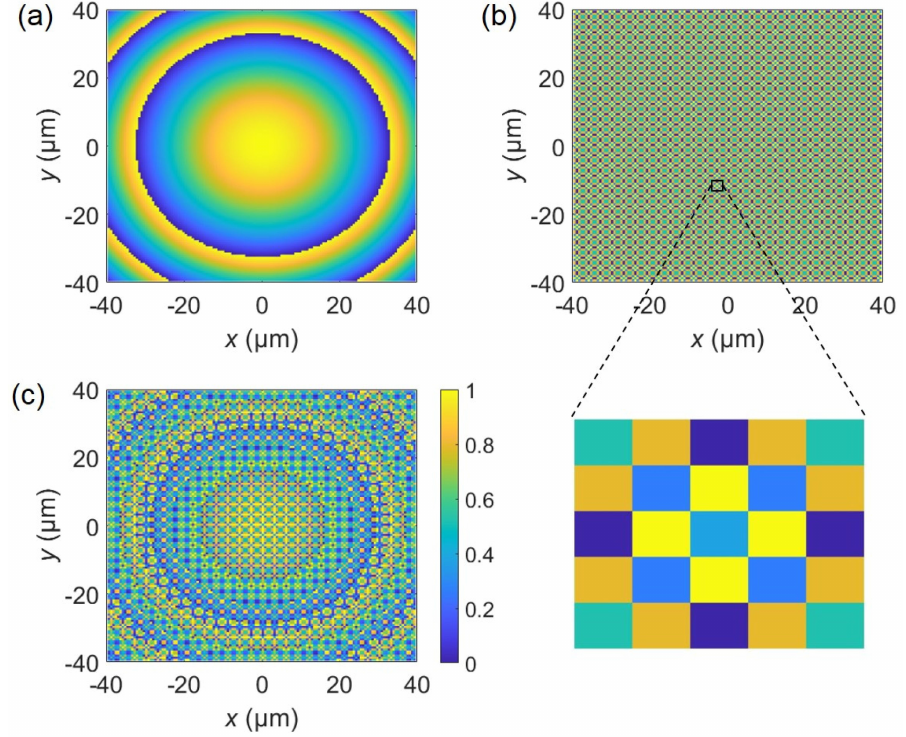
Figure 2. The mechanism of the all-in-one collimating splitter based on metasurfaces. The normalized phase profile of ( a ) the collimating lens ( φ L ), ( b ) Dammann grating ( φ D ) and ( c ) the synthesizing metasurface ( φ ), respectively. The inset of ( b ) is the enlarged view of the Dammann phase profile. The size of the designed metasurface is 80 µ m × 80 µ m, covering the effective area of the incident Gaussian beam. The designed wavelength is 1.55 µ